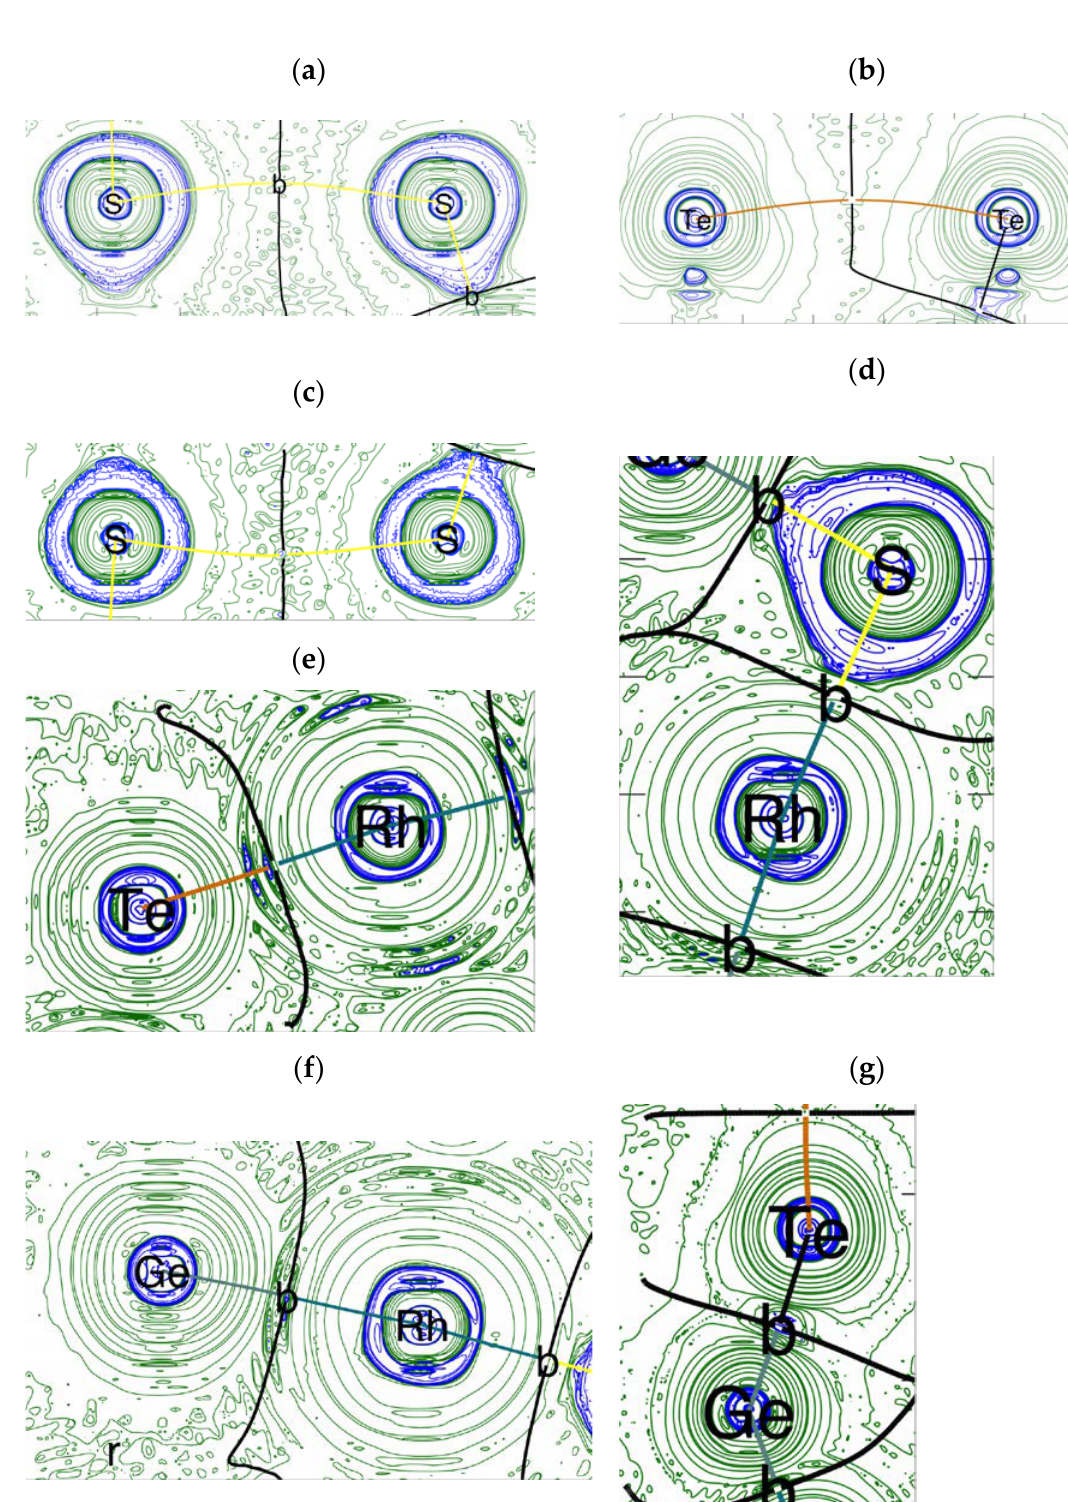
Figure 12. Total energy density ( H ) map of selected pairs of interacting atoms. ( a ) S-S in BaRh 2 Ge 4 S 6 ; ( b ) Te-Te in BaRh 2 Ge 4 Te 6 ; ( c ) S-S in BaRh 2 Ge 4 S 4 Te 2 ; ( d ) Rh-S in BaRh 2 Ge 4 S 6 ; ( e ) Te-Rh in BaRh 2 Ge 4 S 4 Te 2 ; ( f ) Rh-Ge in BaRh 2 Ge 4 S 6 ; ( g ) Ge-Te in BaRh 2 Ge 4 Te 6 . Positive energy in green; negative energy in blue.